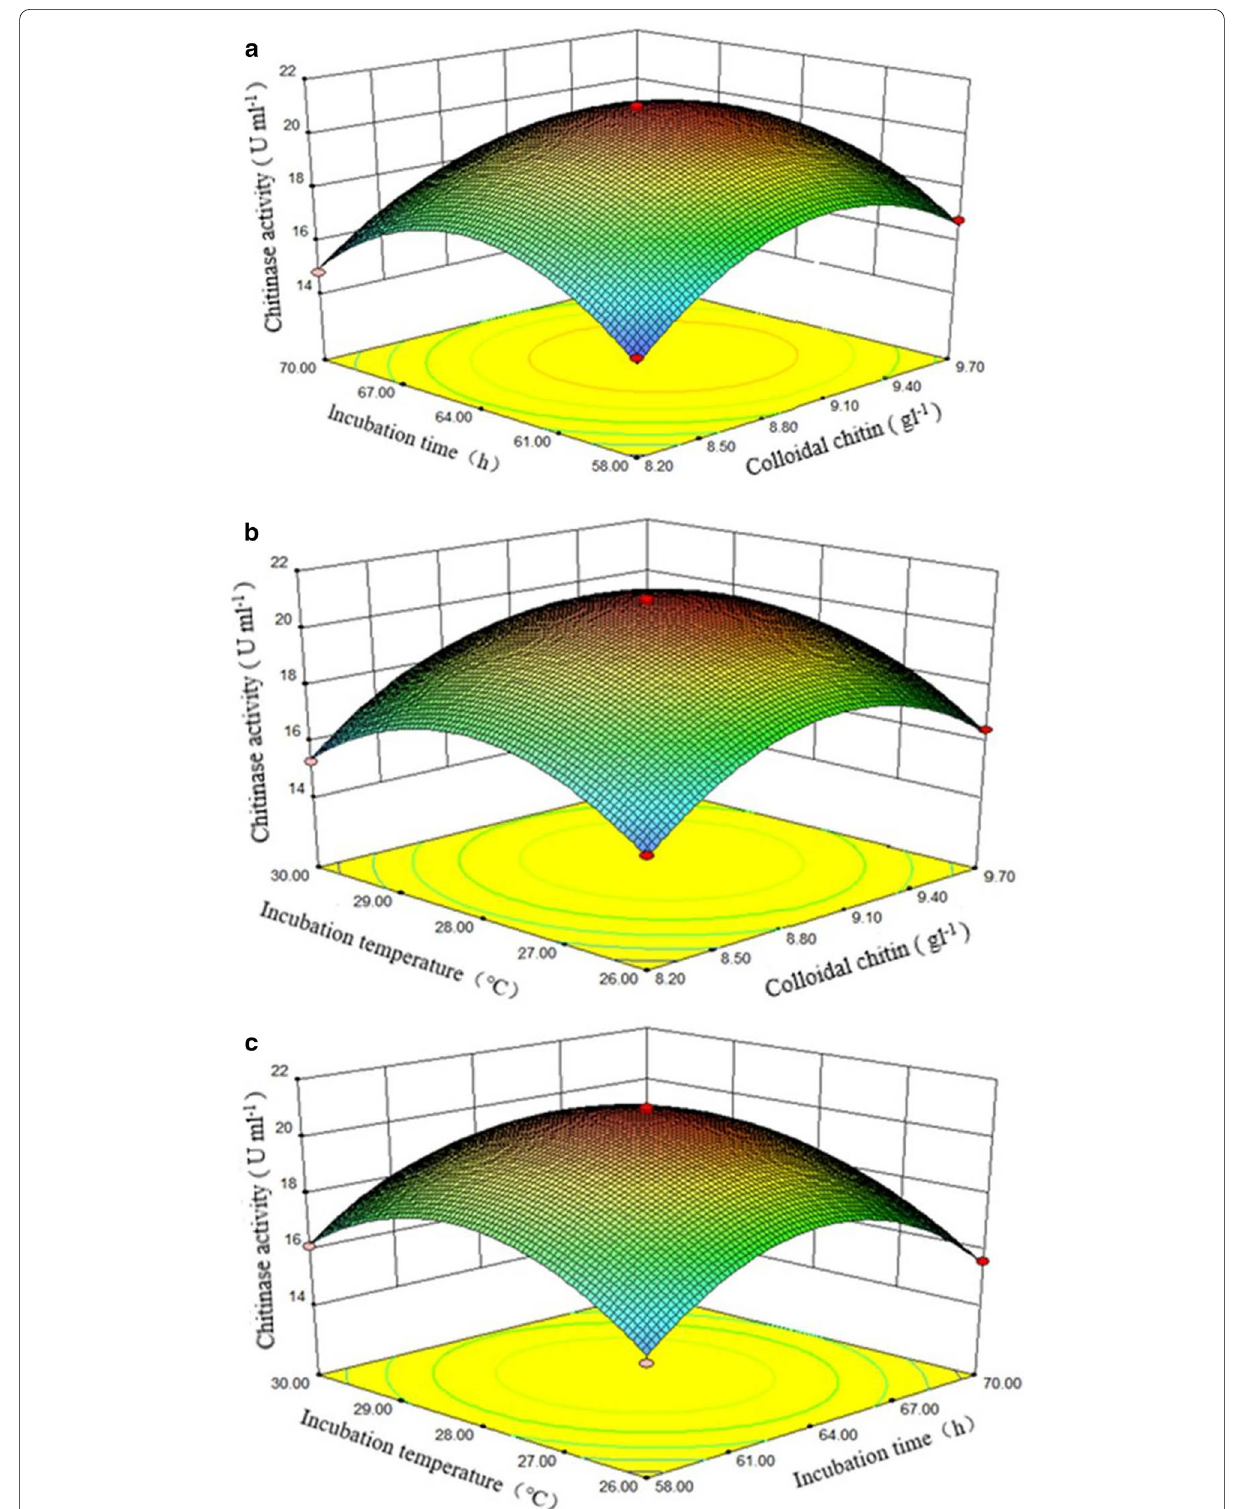
Fig. 3 Response surface and counter plots of the interactive effects on chitinase production by the strain TC‑1 between colloidal chitin concentration and incubation time ( a ), colloidal chitin concentration and incubation temperature ( b ), and incubation time and incubation temperature ( c